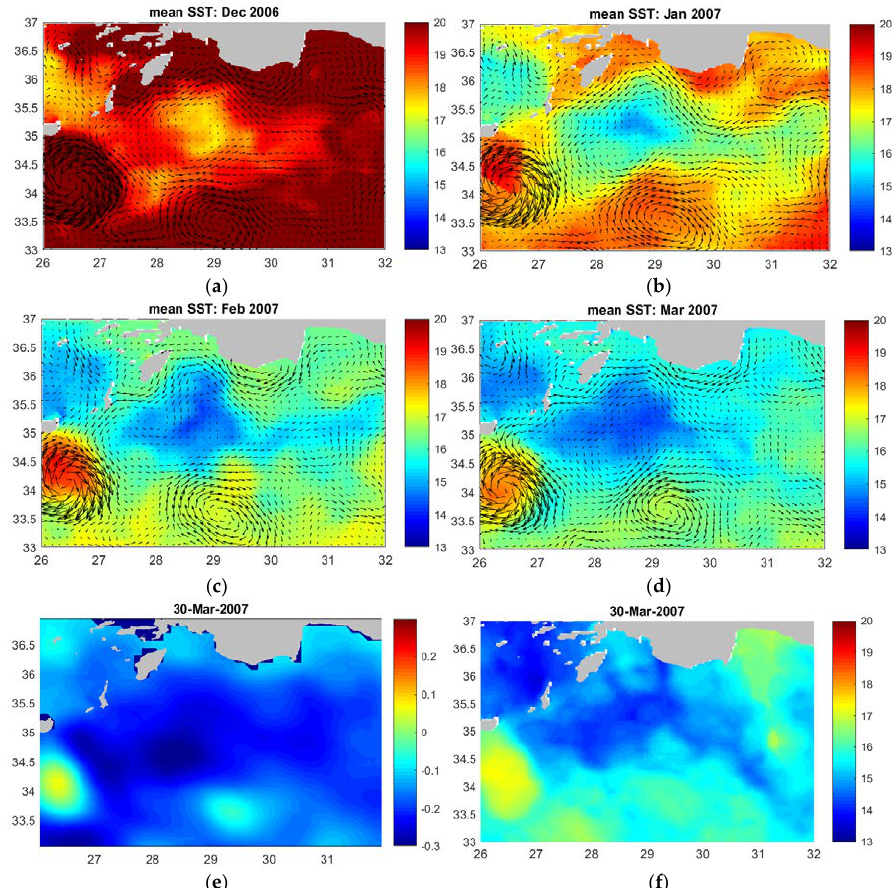
Figure 19. ( a–d ) Monthly mean of satellite SST (°C) from December 2006 to March 2007. ( e ) SSH (m) and ( f ) SST (°C) on 30 March 2007, exhibiting strongest depression of SSH and lowest SST within this area during the whole winter period, coinciding with the deep dense water formation event. The white circle indicates the float position during March 2007. The T/S plot for March 2007 reveals the formation of typical LIW, i.e., potential temperature above 15°C and salinities higher than 39 psu (Figure 20). The potential density lines of 29 – 29.06 × kgm −3 represent the potential density range of typical LIW ([6]; Figure 20).